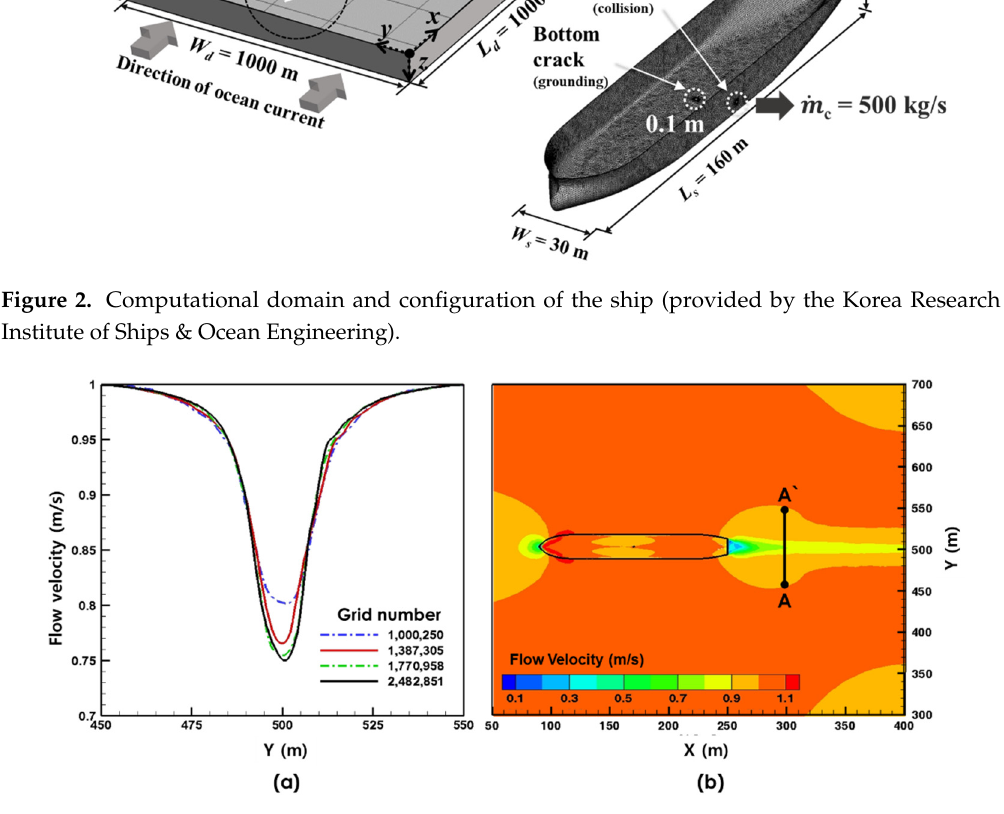
Figure 3. ( a ) Grid convergence test results for the case of v s = 1, v d / v s = 0.5, and d s = 30 m at x = 290 m and z = 0 m, ( b ) along the black solid line A–A`.